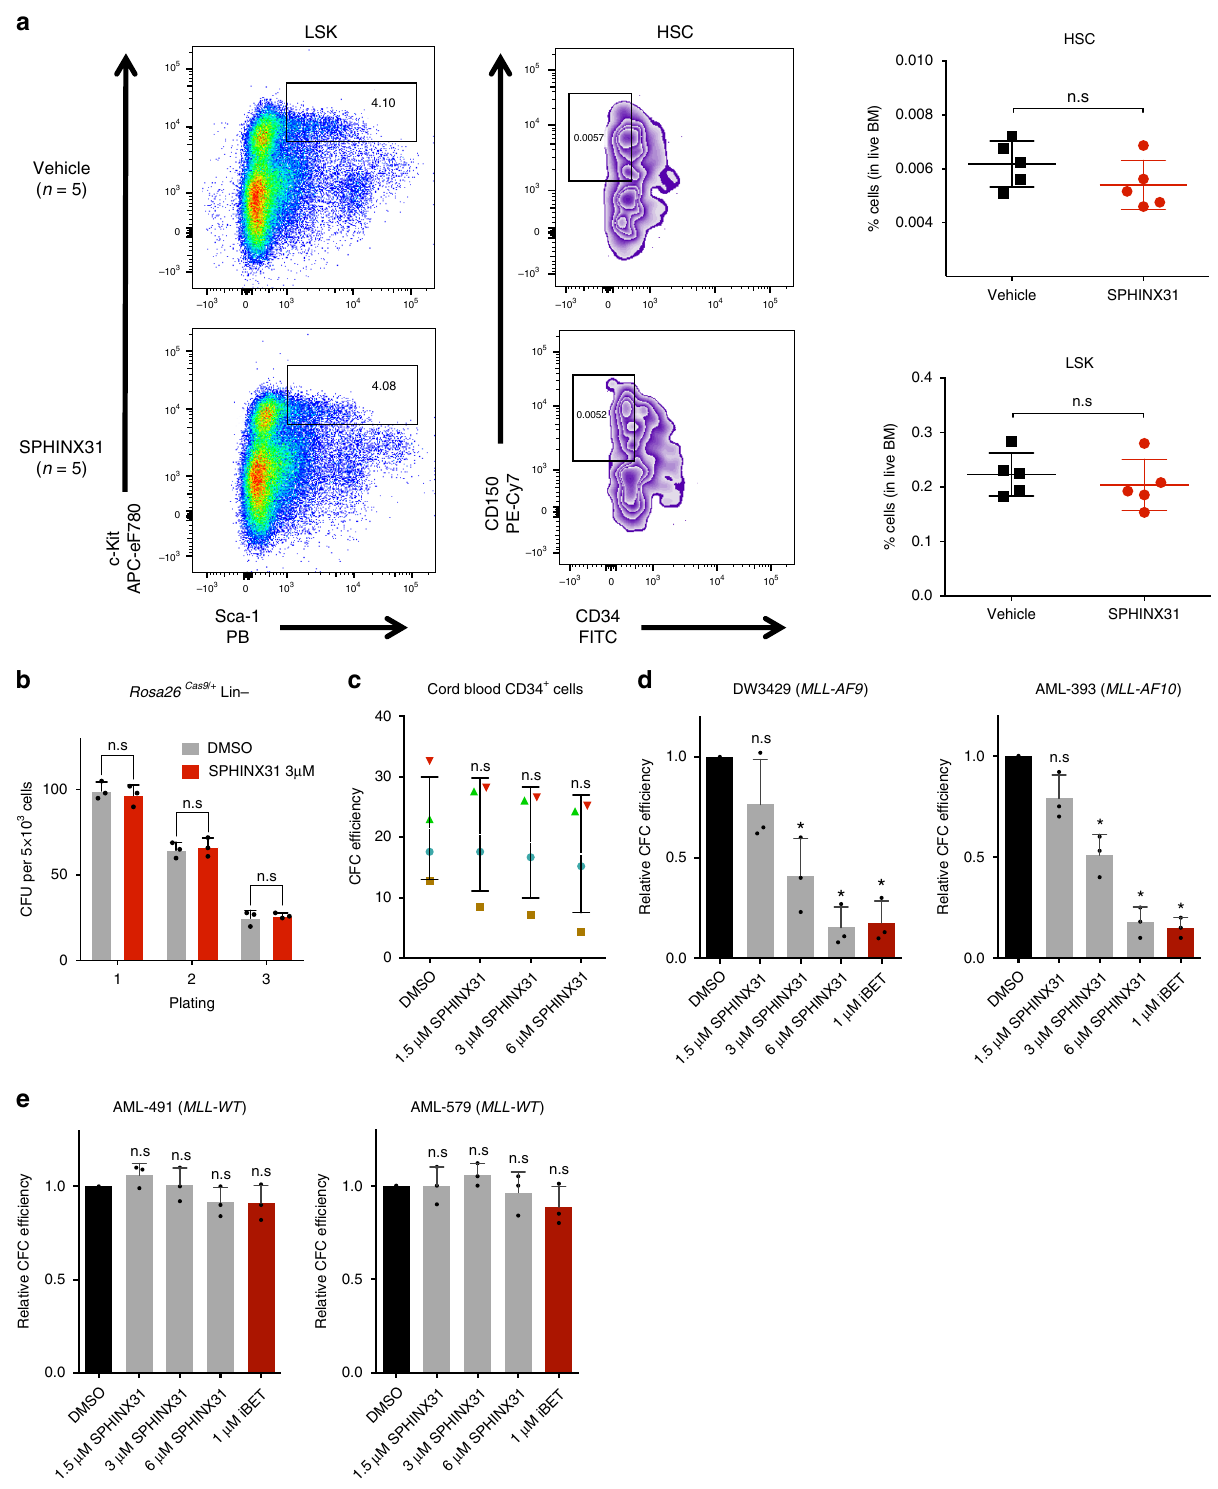
Fig. 2 SRPK1 inhibition has no lasting effects on normal hematopoiesis. a Quantitation of LSK (Lin − /Sca1 + /Kit + ) and HSC (LSK/CD150 + /CD34 − ) compartments in bone marrow from WT mice three weeks after treatment with vehicle or SPHINX31 (2 mg/kg). b Colony-forming assay of WT lineage negative (Lin − ) HSPCs during (plating 1) and after (platings 2 & 3) treatment with 3 μ M SPHINX31 (mean ± s.d., n = 3). c Colony-forming ef fi ciency of CD34 + human cord blood cells ( n = 4) in the presence of 1.5, 3, or 6 uM SPHINX31 (mean ± s.d., n = 4). These changes are not signi fi cant at the 95% con fi dence level according to one-way Anova on repeated measures. Error bars refer to variation across 4 different individuals (blue circle, brown square, red triangle, and green triangle). d Colony-forming ef fi ciency of primary human MLL-X AML cells treated with 1.5, 3, or 6 μ M SPHINX31 or 1 μ M iBET-151 (mean ± s.d., n = 3 technical replicates). e Colony-forming ef fi ciency of primary human MLL-WT AML cells treated with 1.5, 3, or 6 μ M SPHINX31 or 1 μ M iBET-151 (mean± s.d., n = 3 technical replicates). HSC, hematopoietic stem cells; CFU, colony forming units; n.s., not signi fi cant; * p < 0.001 ( t